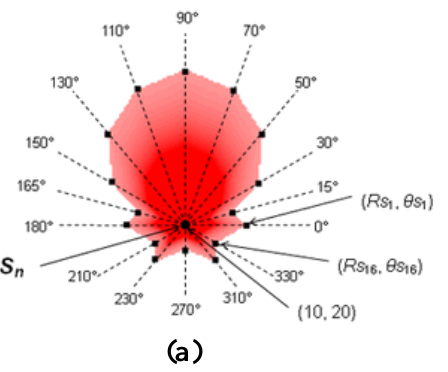
Figure 3. A directional sensing area approximated by the polygon